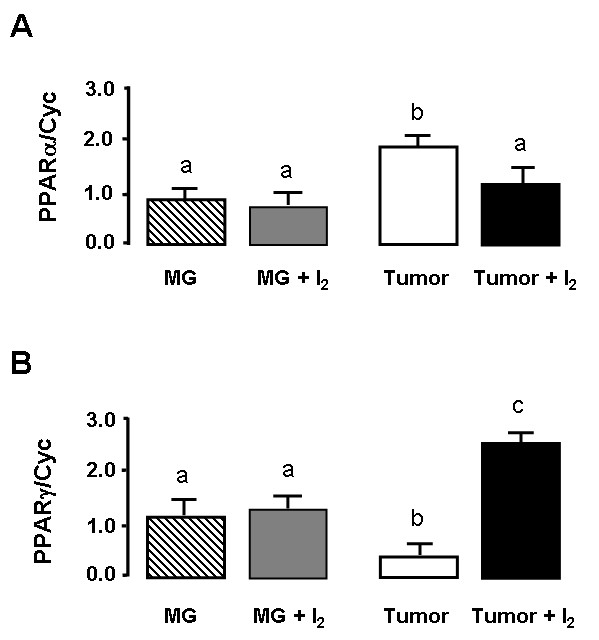
PPAR expression. Isoforms of PPAR mRNA in normal (MG) or tumoral (tumor) mammary glands from control or I2-treated rats were measured by the real time PCR method. A, PPAR type alpha (PPARα). B, PPAR type gamma (PPARγ). Cyclophilin (Cyc) served as internal control and was used to normalize for differences in input RNA. Data are expressed as the mean ± SD. Differences between experimental groups were analyzed using a one-way ANOVA and the Tukey-HSD Test. Means with different letters are significantly different (p < 0.05)